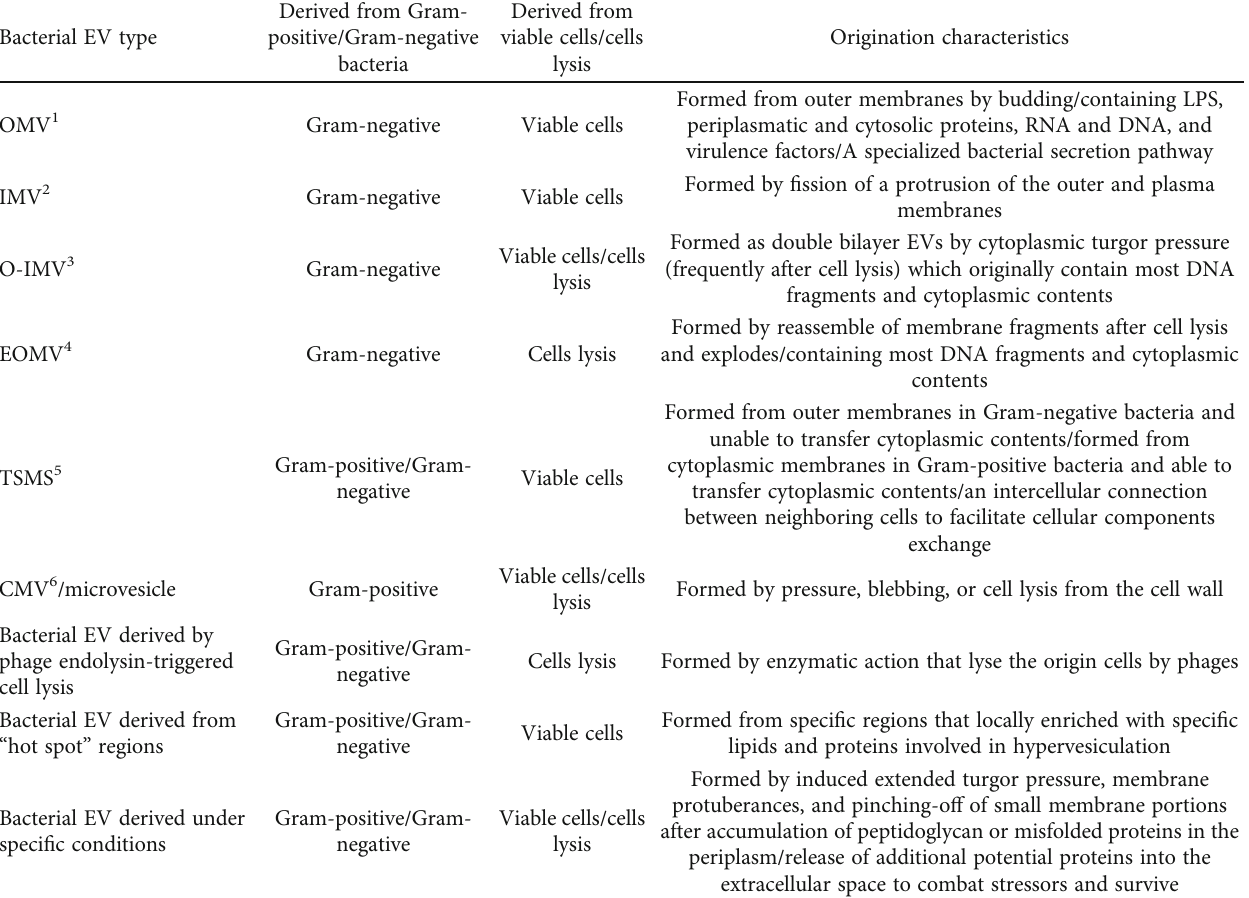
Table 1: The characteristics of di ff erent types of bacterial